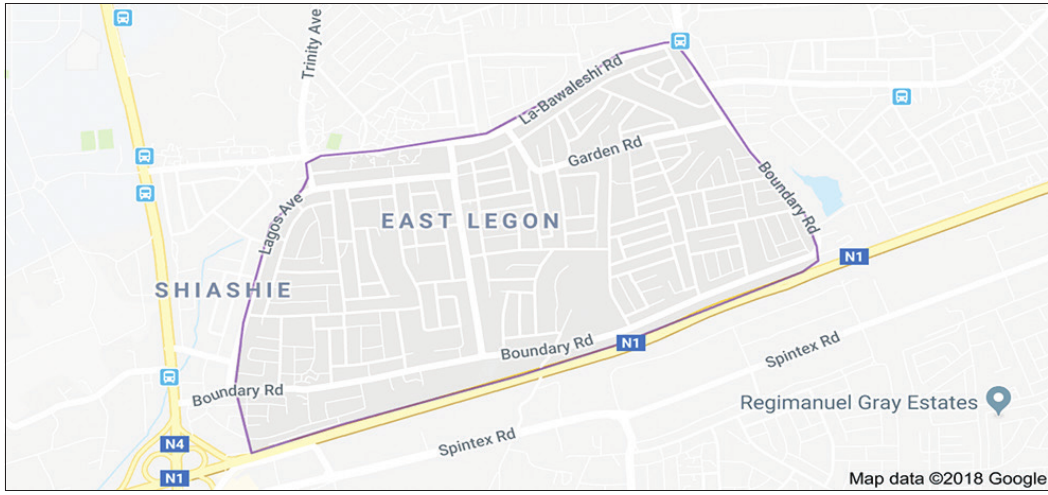
Figure-1: Map of East Legon. Source: Google